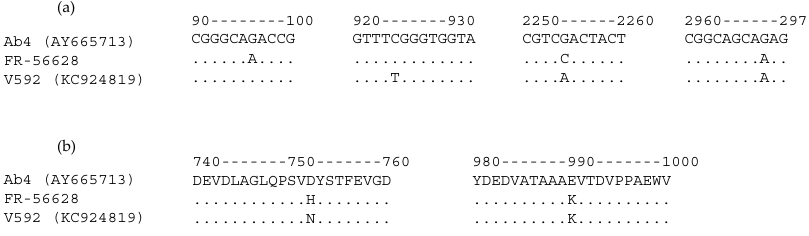
Figure 4. Open reading frame 30 (ORF30) nucleotide ( a ) and amino acid ( b ) sequence alignments between the EHV-1 reference strains Ab4, V592 and the newly isolated strain FR-56628. Three dimensional models of the DNA polymerase were obtained based on the homology of the ORF30 amino acid sequences from EHV-1 strains Ab4 (G 2254 ), V592 (A 2254 ) and FR-56628 (C 2254 ) with herpes simplex virus 1 (HSV-1) (Figure 5). The amino acid residue in position 752 is located in the palm domain and remains close to the fingers domain. After analysis of the sequence by Phyre2 function (data not shown).